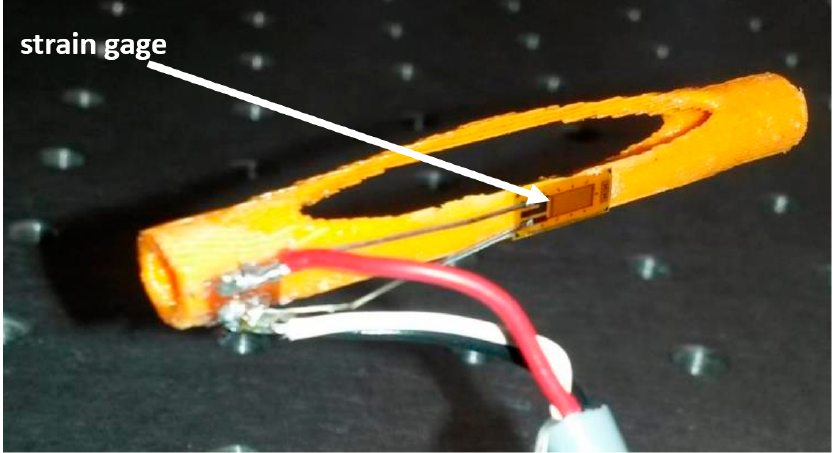
Figure 12. Prototype of a single cell.